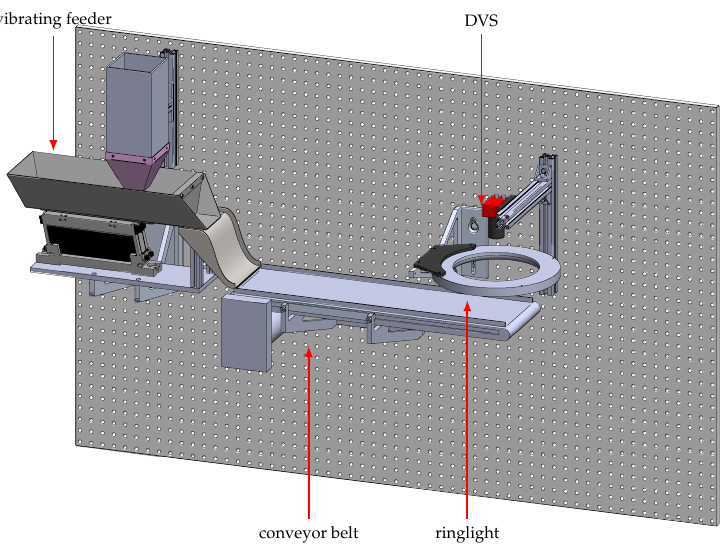
Figure 7. Experimental setup to generate the event-based bean dataset. Two different types of beans are considered: white beans without a pattern and Borlotti beans that are spotted with red dots and random texture. Being spread out by the shaker, the beans move towards the conveyor belt successively. Once a bean slid down the ramp the belt conveys it through the camera’s FoV at a speed of approximately 1.1ms − 1 .